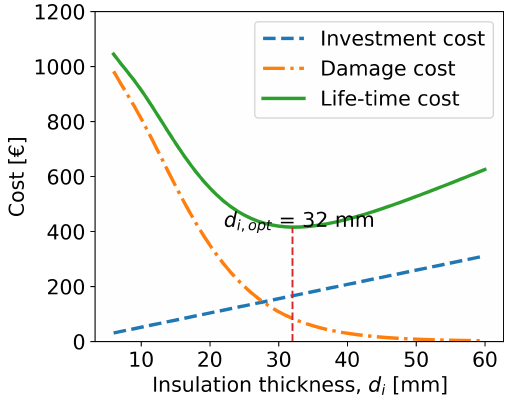
Figure 3. Investment, failure and life-time cost for a specific fire scenario case of steel column (qf = 800 MJ/m 2 and O = 0.04 m 1 / 2 ). Optimum SFRM thickness, d i,opt of 32 mm obtained for the